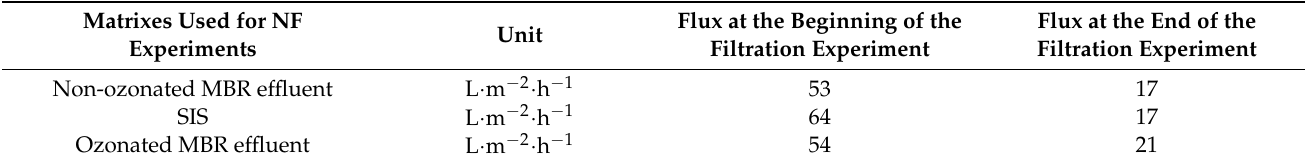
Table 4. Values of permeate flux at the beginning and end of studied NF experiments. Matrixes Used for